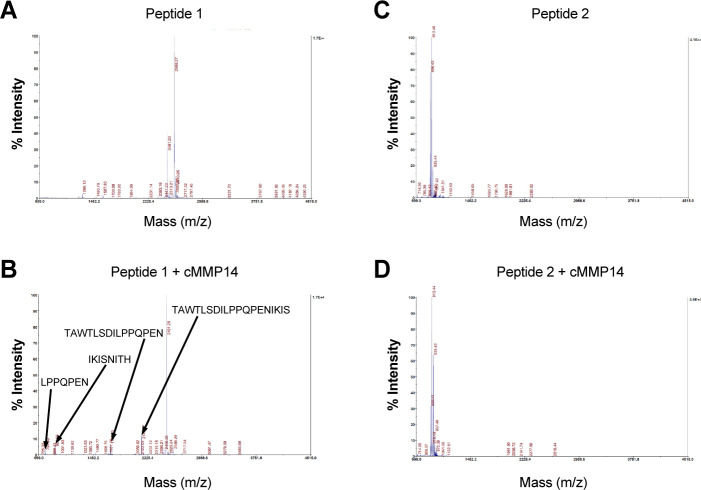
Recombinant MMP14 cleaves Tie2 polypeptides.Mass spectrometry analyses after incubating two Tie2 polypeptides 630T–652H (peptide 1) and 736Q–745K (peptide 2) with the recombinant catalytic domain of MMP14 (cMMP14). (A) The intact peptide-one with MH+2588.3 (B) Peptide-one was completely digested into smaller fragments in the presence of recombinant MMP14. The fragments at MH+ 794.39, MH+ 925.53, MH+1703.80 and MH+2140.07 were further identified as LPPQPEN, IKISNITH, TAWTLSDILPPQPEN and TAWTLSDILPPQPENIKIS respectively, by tandem MS/MS. The signal at m/z 2491.26 is probably a product from incomplete synthesis, as it is already present in the synthetic peptide before digest. (C) Intact peptide-two with MH+ 913.4 (D) Peptide-two remained unchanged in the presence of recombinant MMP14.